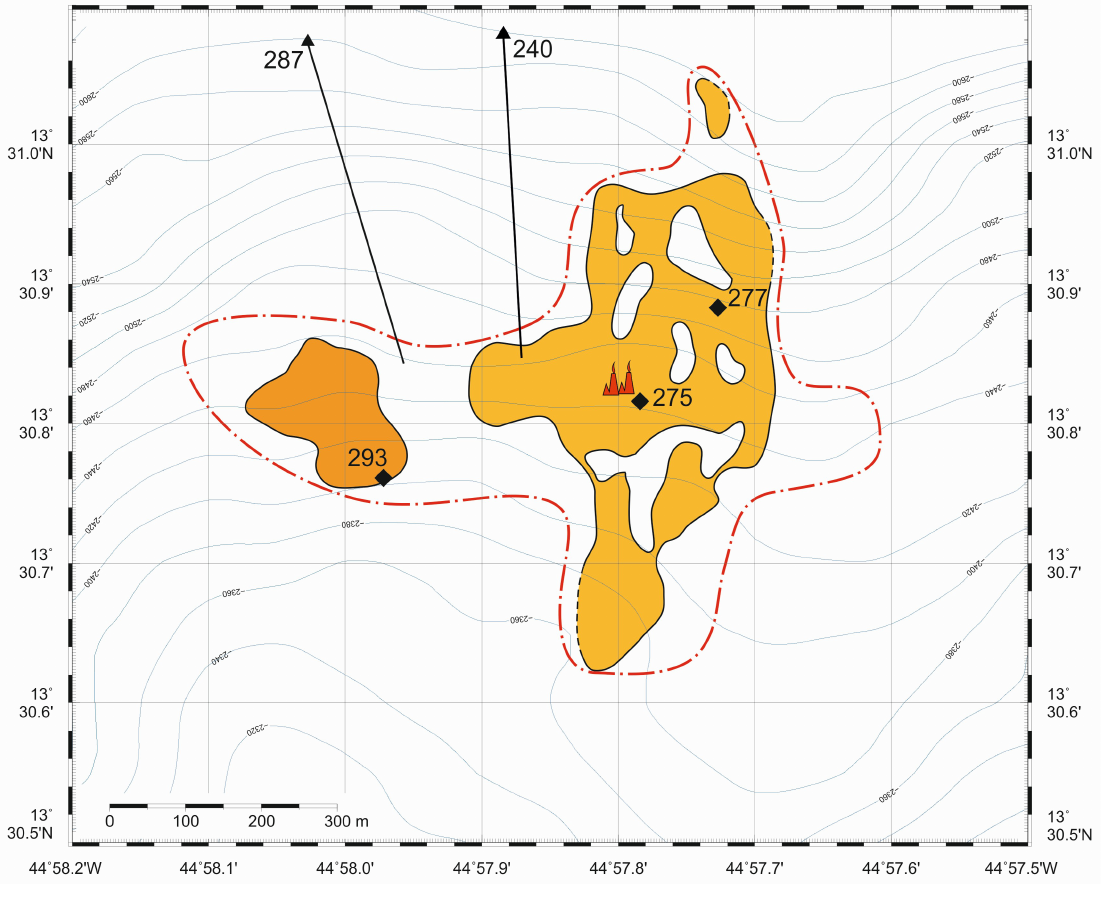
Figure 2. Semyenov-2 hydrothermal field. The red dashed line outlines the Semyenov-2 field. Red figures are active edifices detected by video profiling. Triangles with station numbers are the start point of dredging. Black lines show the tracks of dredging. Rhombs indicate grab samples with station numbers. This figure is simplified from unpublished Polar Marine Geosurvey Expedition (PMGE) open-file reports